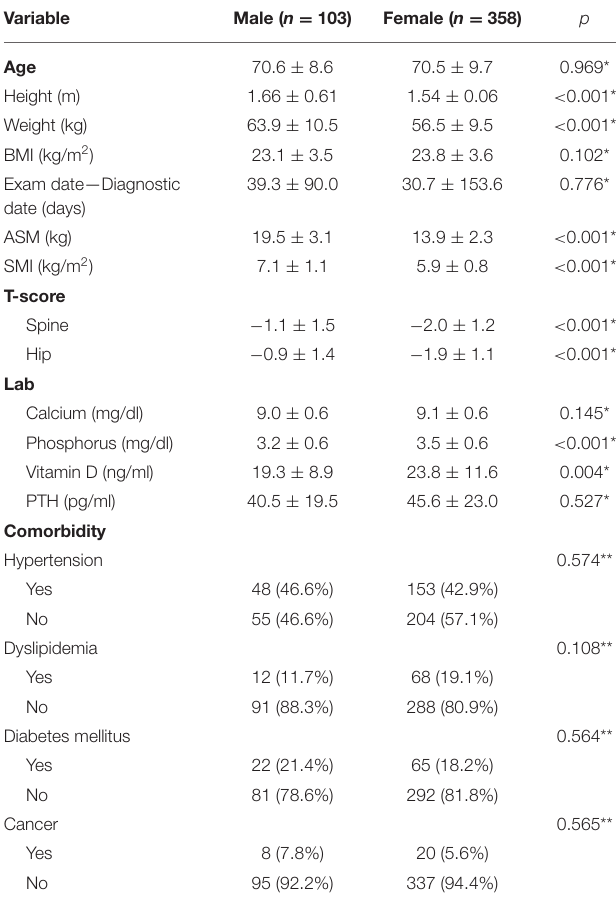
TABLE 1 | Demographic characteristics between both